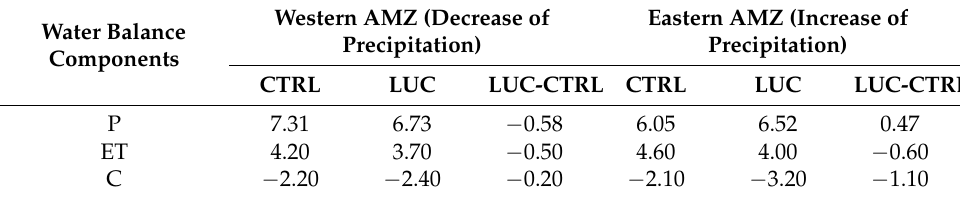
Table 1. Annual mean (1980–2009) of water balance components: precipitation (P, mm day − 1 ), evapotranspiration (ET, mm day − 1 ) and convergence of moisture flux (C, mm day − 1 ), calculated for western and eastern AMZ boxes showed in Figure